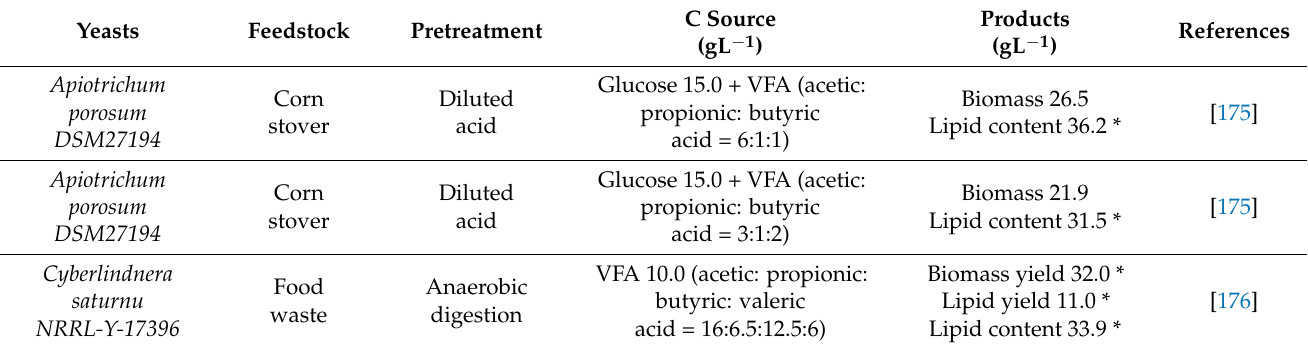
Table 5. Use of oleaginous yeasts on different food wastes and main products derived from yeast metabolism. * = (%, w/w)